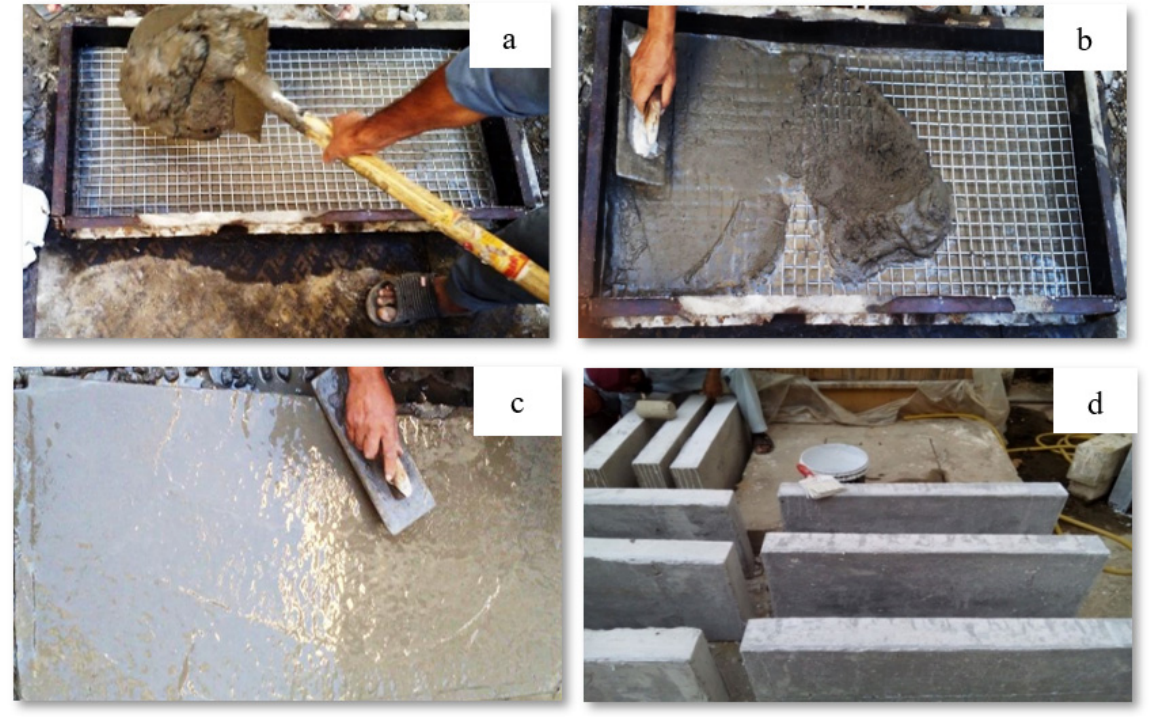
Figure 6. ( a ) Placing of ferrocement mesh and mortar; ( b ) Spreading of mortar over the mesh with a trowel; ( c ) Final finish with a trowel; ( d ) Whitewash on sides of slabs.